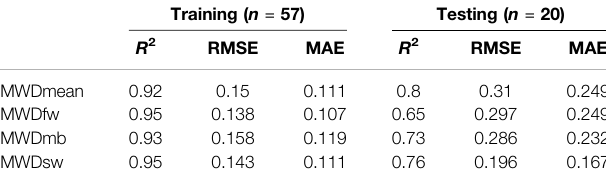
TABLE 2 | FCR training and testing results for different MWD